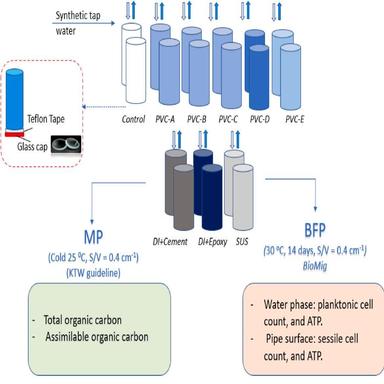
Migration potential (MP) and biomass formation potential (BFP) tests of selected water pipes.